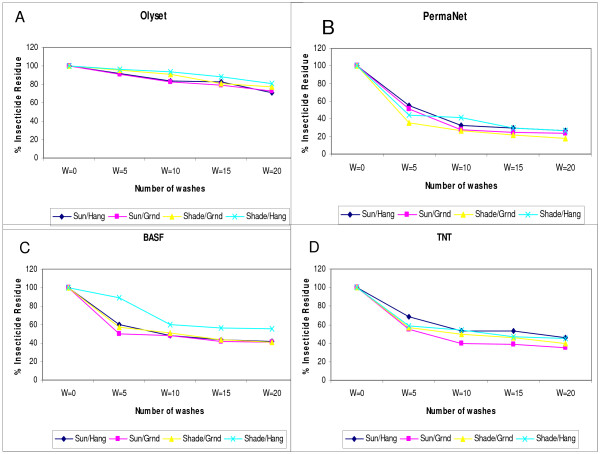
Percent insecticide residue per net brand and per drying regimens.